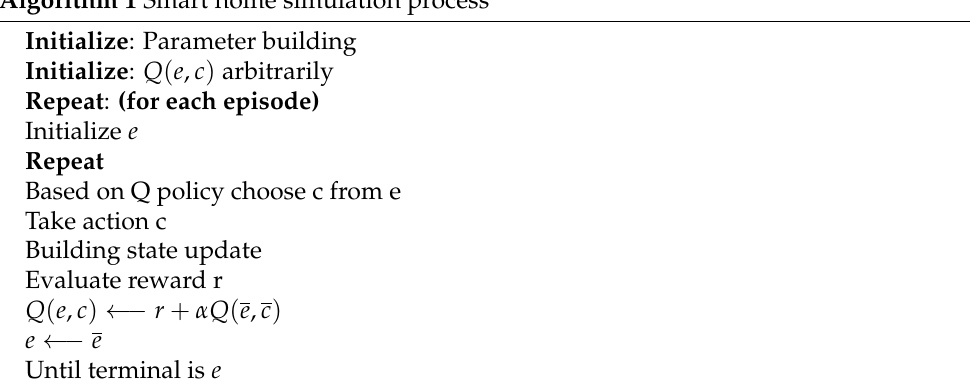
Algorithm 1 Smart home simulation